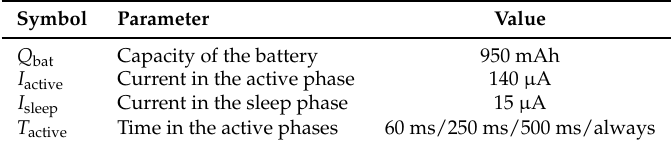
Table 1. Parameters used for calculating the life span of the wake-up